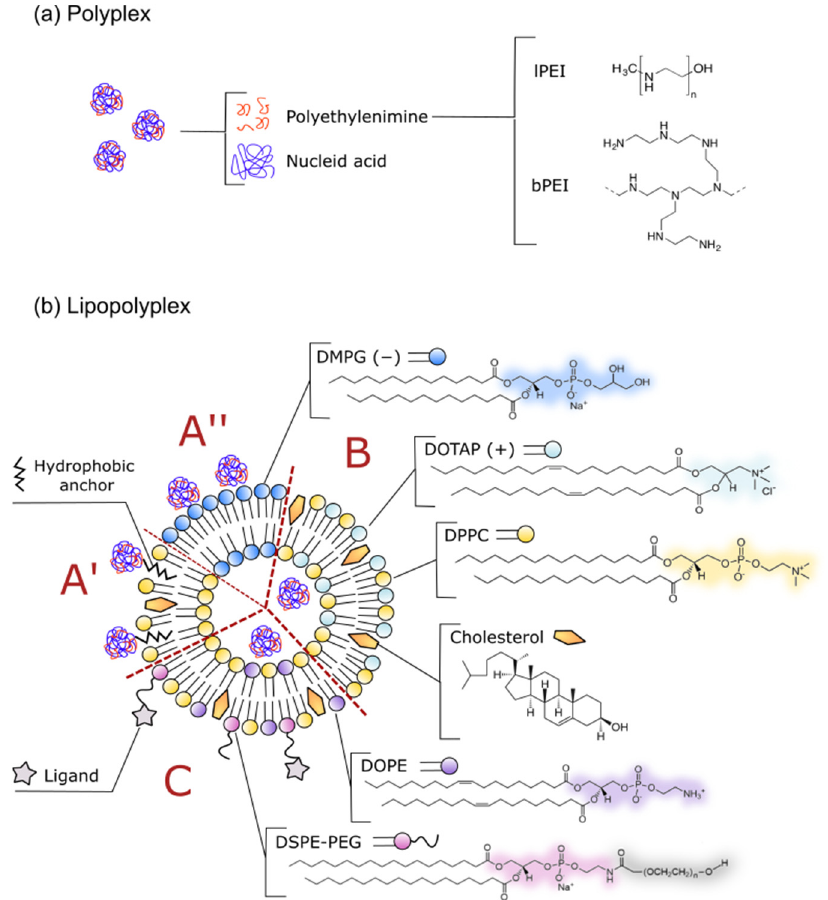
Figure 1. Structure and components of various polyethyleneimine-based lipopolyplex carriers for gene delivery. A’—Reversed lipopolyplexes with polyethyleneimine bound covalently to hydrophobic anchor (e.g., triamcinolone acetonide) embedded in a neutral lipid bilayer; A”—reversed lipopolyplexes composed of anionic lipids that enable docking of positively charged polyplexes based on polyethyleneimine; B—“classical” lipopolyplexes with the addition of cationic lipids; C— lipopolyplex with targeting ligands (e.g., antibodies, transferrin, aptamers) conjugated to the surface via polyethylene glycol (PEG) modified lipids. bPEI—branched polyethyleneimine; DMPG— 1.2-dimyristoyl-sn-glycero-3-phospho-(1 ′ -rac-glycerol) (sodium salt), negatively charged; DOPE— 1.2-dioleoyl-sn-glycero-3-phosphoethanolamine; DOTAP—1.2-dioleoyl-3- trimethylammonium-propane (chloride salt), positively charged; DPPC—1.2-dipalmitoyl-sn-glycero- 3-phosphocholine; DSPE-PEG—1.2-distearoyl-sn-glycero-3-phosphorylethanolamine